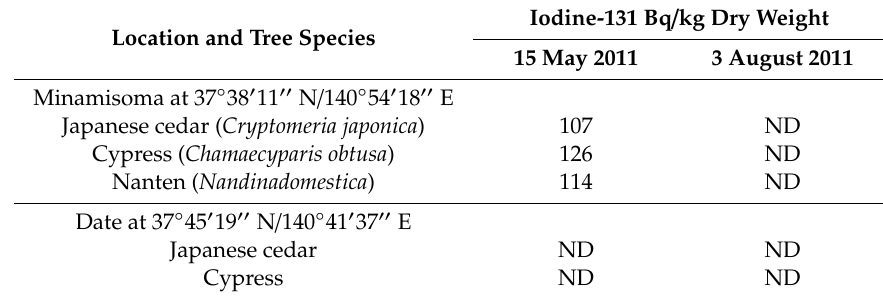
Table 1. Fallout iodine-131 specific activities in leaves with stems in Fukushima